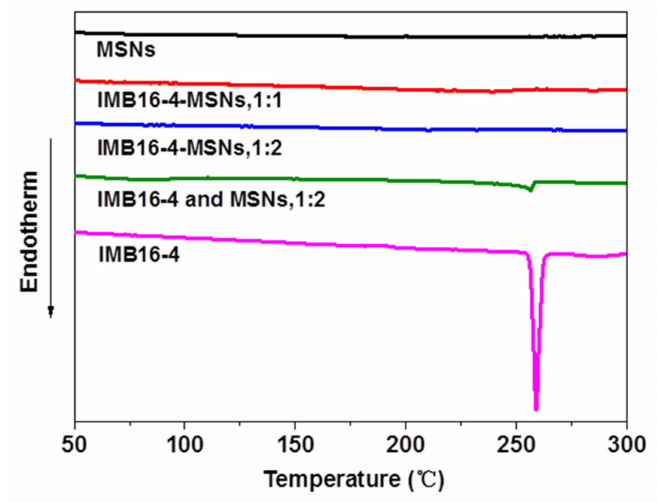
Figure 4. Differential scanning calorimetry (DSC) graphs of MSNs, physical mixture and IMB16-4-MSNs.